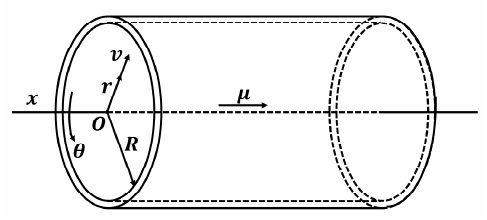
Figure 1. Vascular model.